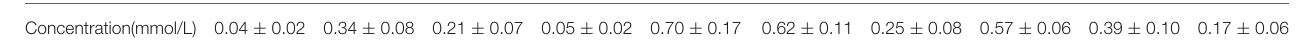
TABLE 1 | Concentration of different metabolites relative to TMSP (means ± SEM) in the rats’ ELGs. Metabolites Glu 3 Glx 3 Glu 4 Asp 2 Cre(N-CH 3 ) Tau